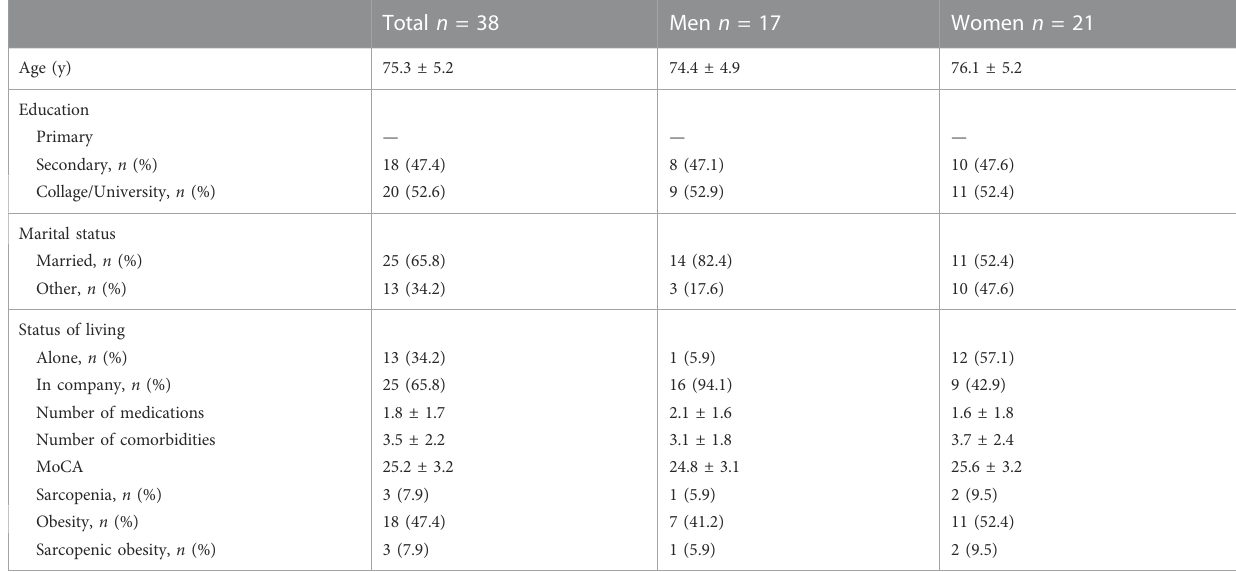
TABLE 1 General characteristics of the study participants.